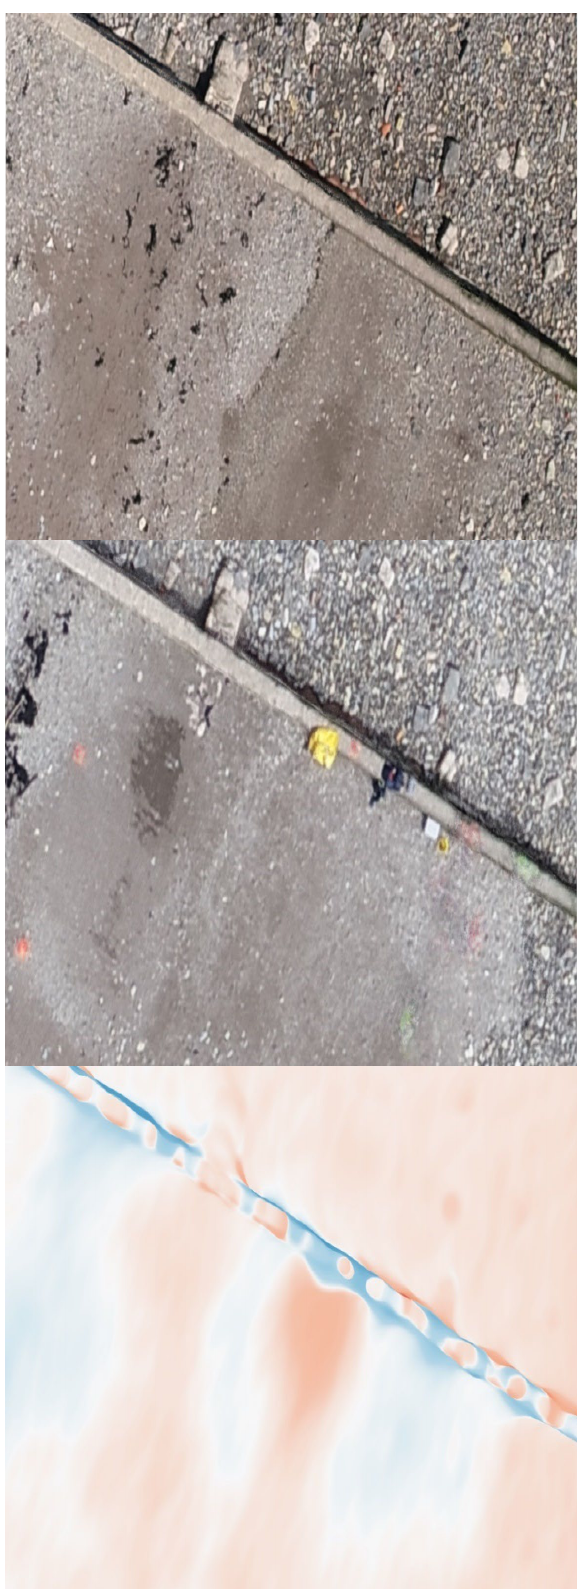
Figure 19 - Close-up View of the Area around the Groyne. (Survey 1, 2 and Difference Map respectively).